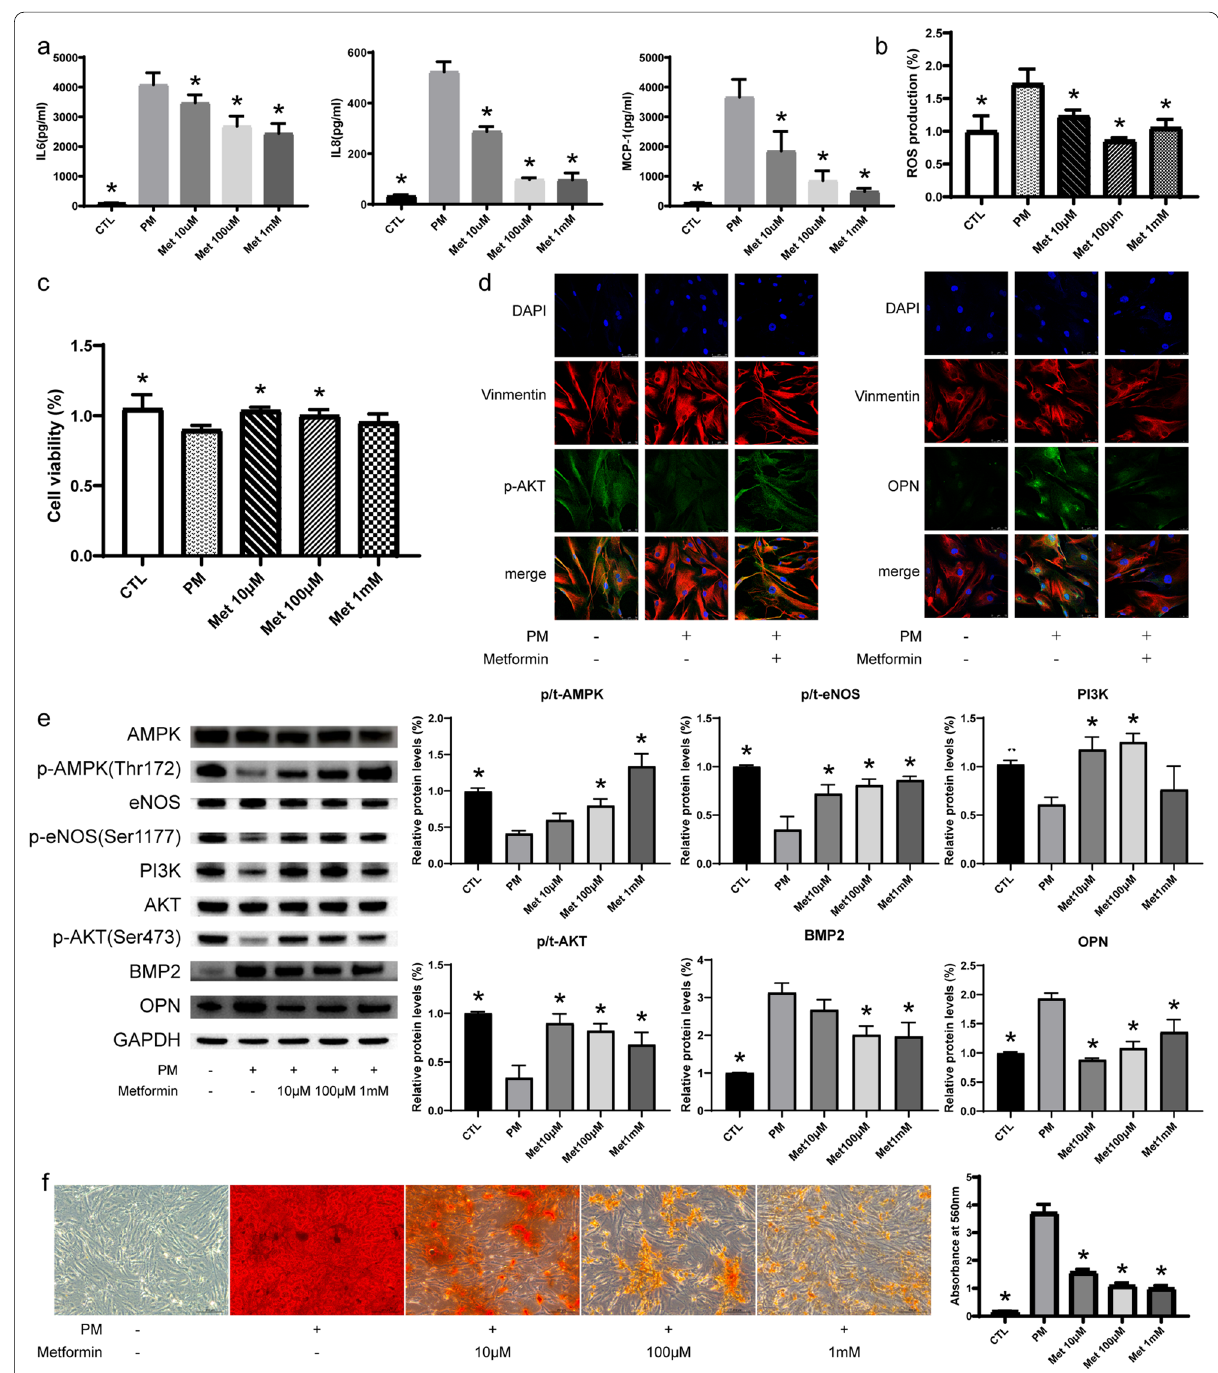
Fig. 4 Metformin alleviates aortic calcification by activating the PI3K/AKT signaling pathway in a concentration-dependent manner in vitro. a Metformin inhibits inflammatory factor secretion including IL6, IL8, and MCP-1 in cell supernatant, after treatment with phosphate medium (PM) with or without metformin for 72 h as determined by ELISA; b ROS production was detected and quantified after PM treatment with or without metformin for 72 h; c Cell viability was detected by CCK8 after treatment with PM with or without metformin for 72 h; d Immunofluorescence staining images of p-AKT and OPN expression in AVICs after PM treatment with or without 100 μM metformin for 72 h, Scale bar, 50 μm; e The protein expression of p-AMPK (Thr172), p-AKT (Ser473), PI3K, p-eNOS (Ser1177), BMP2, and OPN in AVICs after PM treatment with or without metformin for 72 h as determined by WB; f Calcium deposition were detected by ARS Staining after various treatments for 7 days, Scale bar, 200 μm. n 6 per group. CTL, control; Met, metformin; *p < 0.05 versus PM group (one-way ANOVA with Bonferroni post hoc =